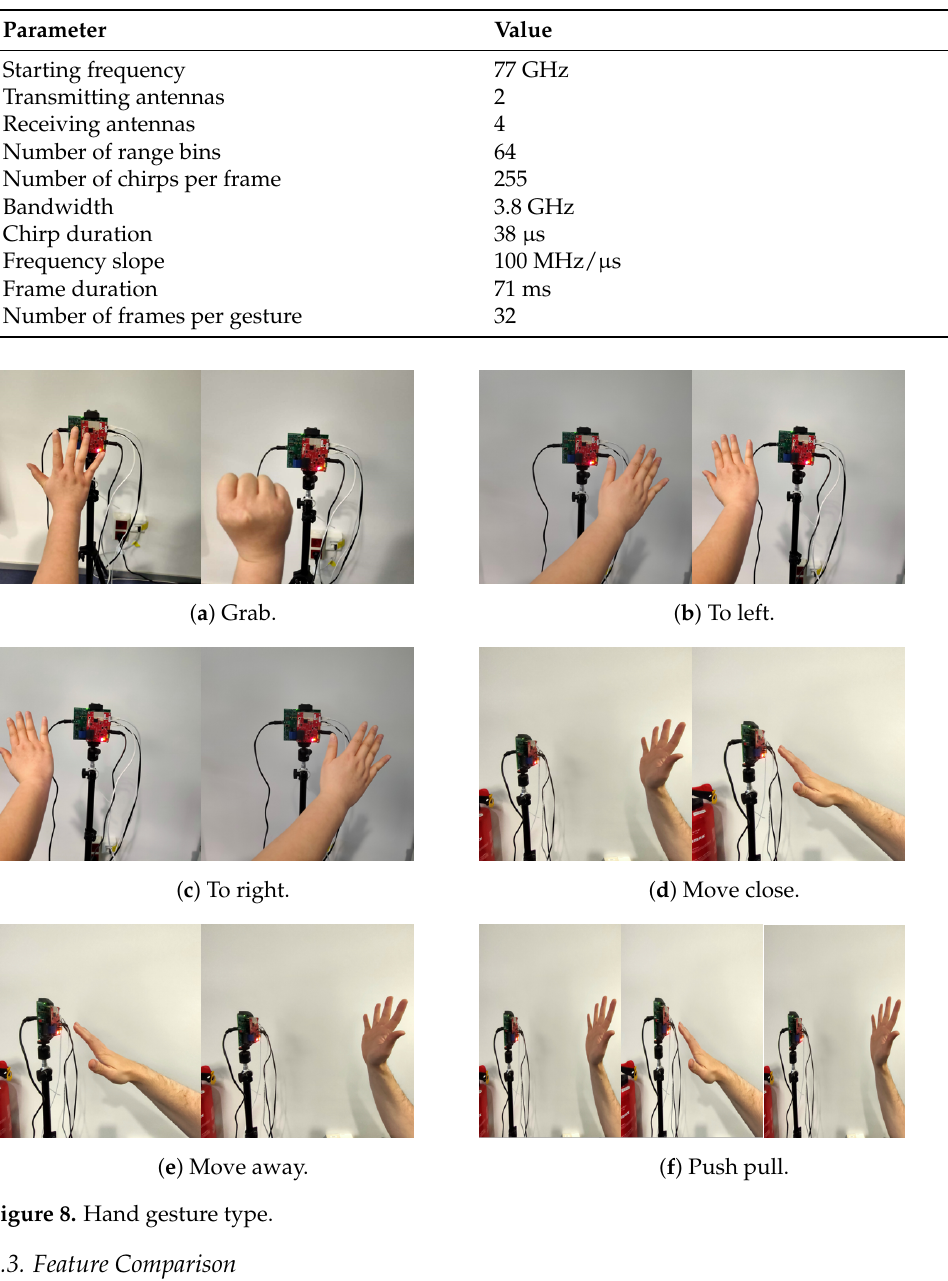
Table 1. Radar parameters.